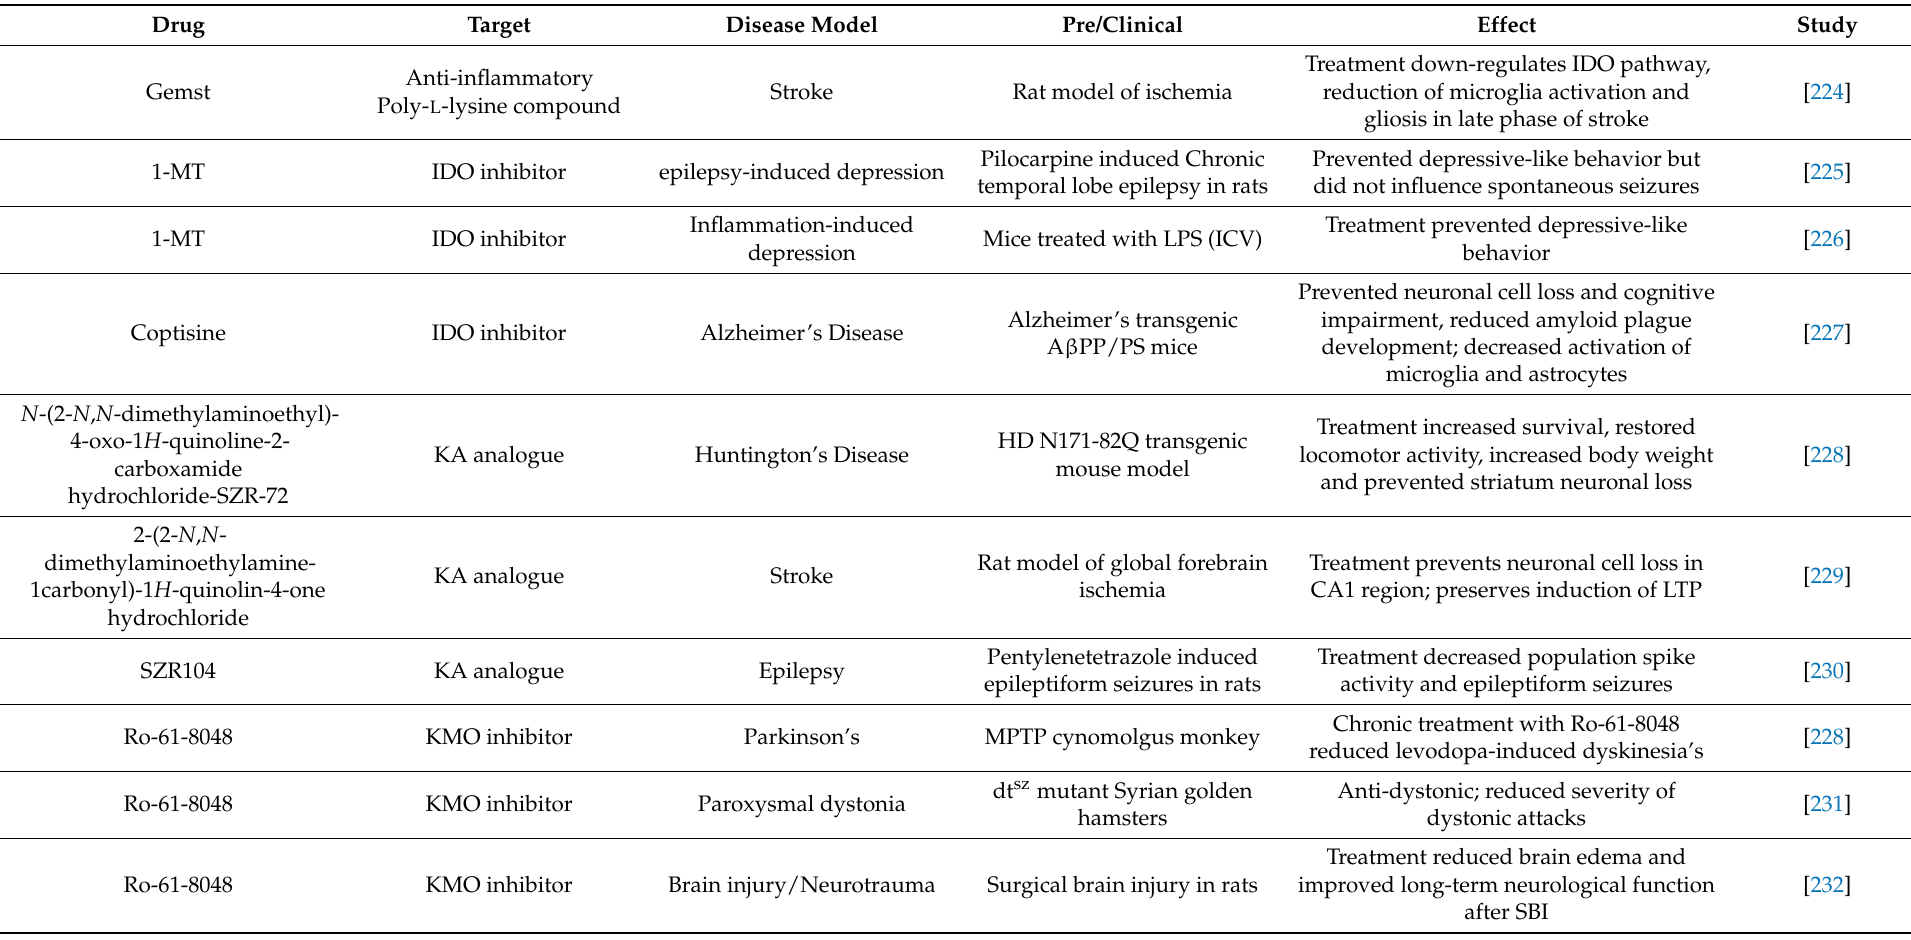
Table 2. List of pharmacological treatments targeting KP Metabolism and neuroinflammation and evaluating treatment outcomes in CNS disease models. A wide variety of therapeutic compounds have been evaluated that directly target KP enzymes or other receptor systems which limit neurotoxic KP metabolite accumulation and associated improvement in cellular, molecular, biochemical and behavioral indices are summarized in Table